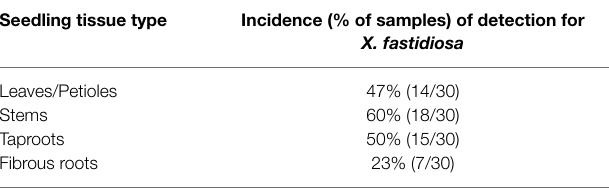
TABLE 2 | Xylella fastidiosa detection in seedling